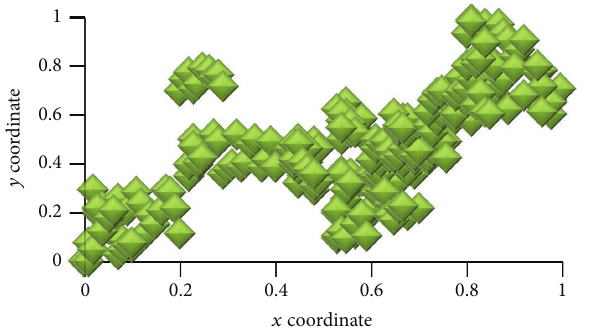
Figure 3: New position of agents after applying cooling algorithm.